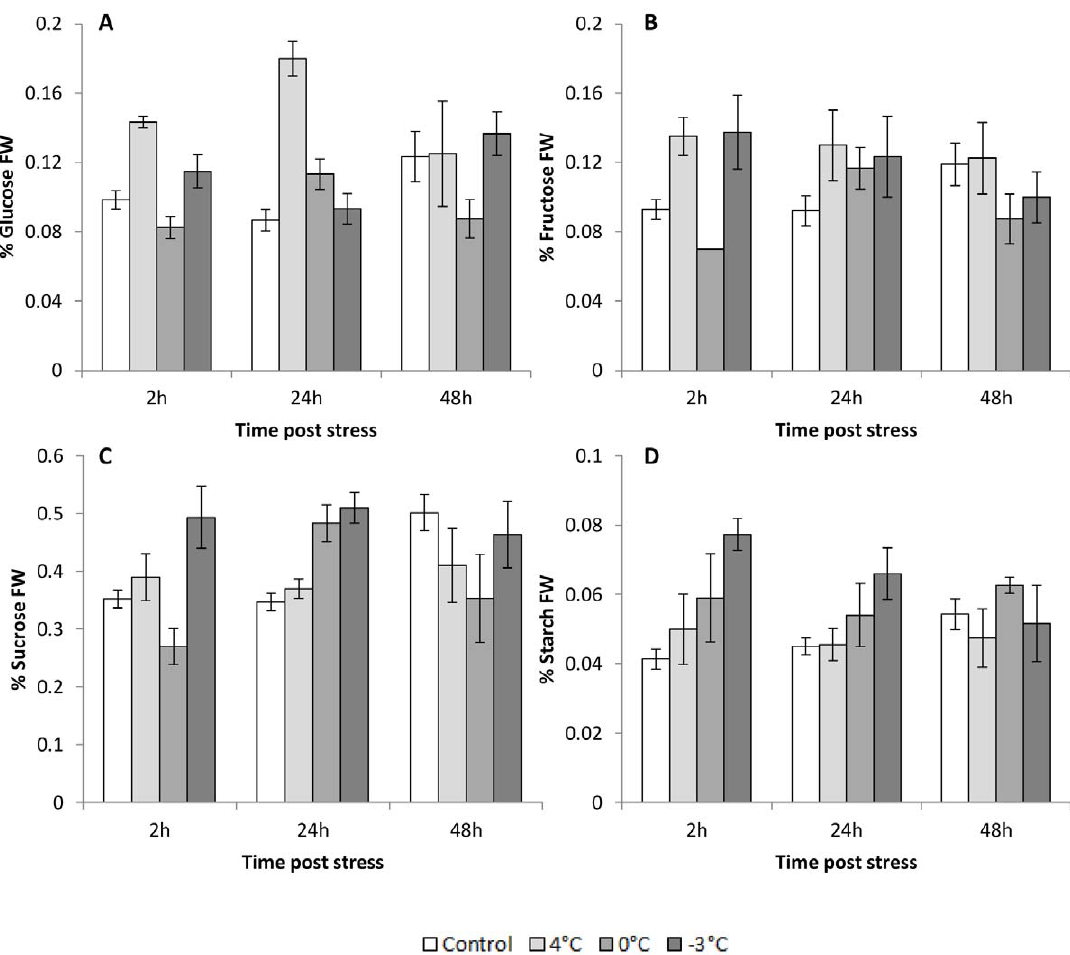
Figure 5. Content, expressed as % fresh weight (FW), of (A) glucose, (B) fructose, (C) sucrose and (D) starch in control and 4 6 C, 0 6 C or 2 3 6 C-treated inflorescences. Measurements were performed 2, 24 and 48 h after cold treatment. Values are means 6 standard errors (n=27).